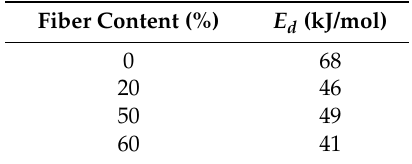
Table 4. E d of PA11 and PA11